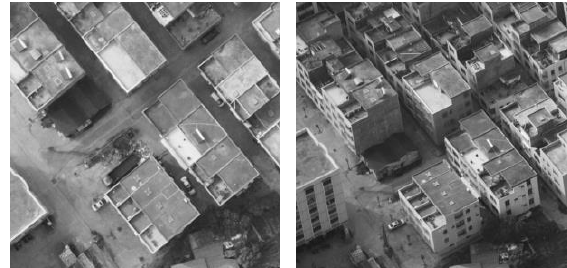
Figure 7. Dataset 2: low-altitude oblique images. Image size is 1024×1024 pixels. Image resolution is 0.08m.